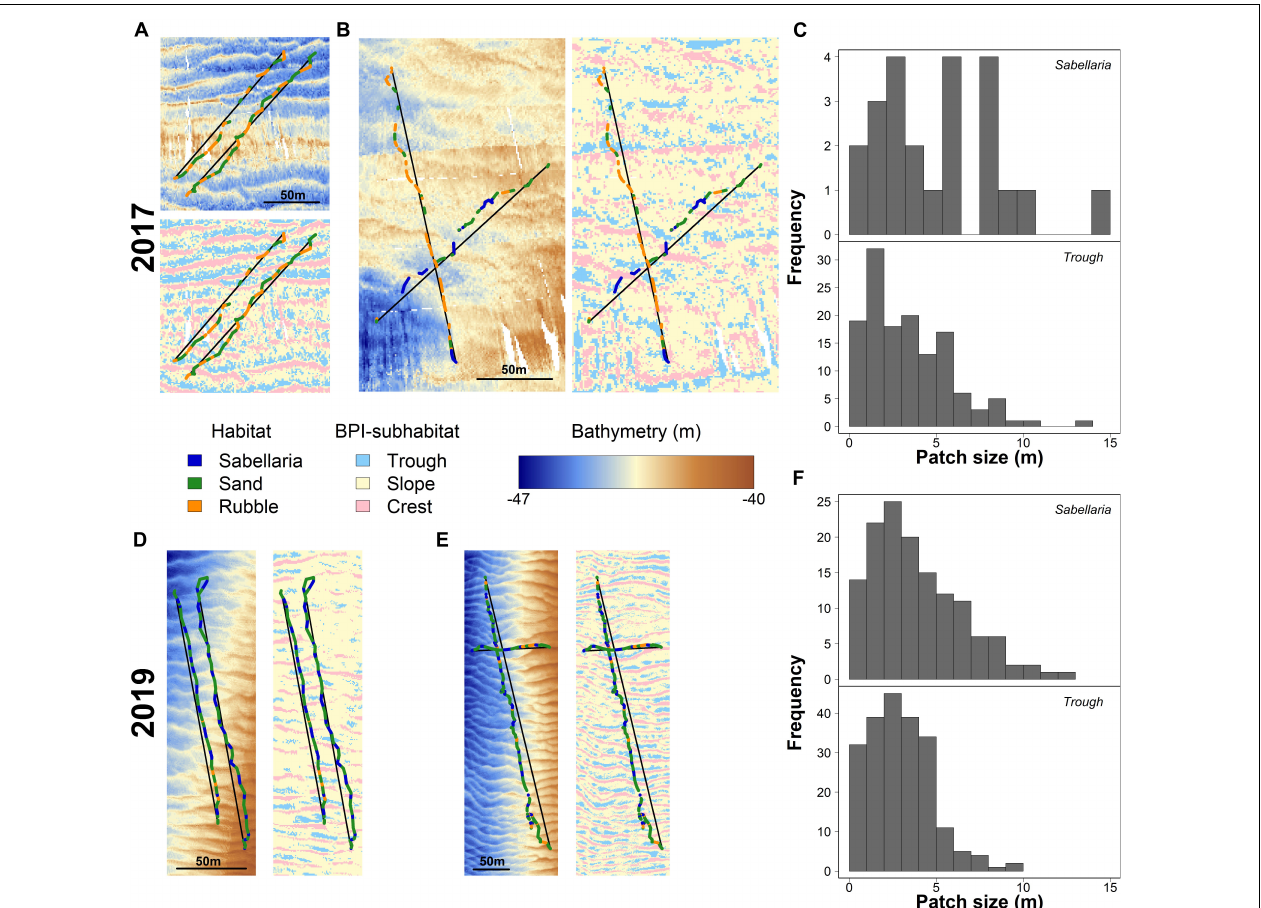
FIGURE 4 | Habitat patch distributions and their link to seafloor morphology for 2017 (A–C) and 2019 (D–F) . (A) detailed maps showing the bathymetry and BPI-subhabitats surrounding the video-observed habitat patches (Sabellaria in blue, Sand in green, and Rubble in Orange) for two representative video transects gathered in 2017 in the western trough. Black lines represent the line segments used to determine BPI-subhabitat sizes. Similar maps of bathymetry and BPI-subhabitat overlayed with video-observed habitats are shown for (B) 2017, eastern trough, (D) 2019, western trough, and (E) 2019, eastern trough. Histograms show the absolute frequency of the sizes for the video-observed Sabellaria habitat patches and BPI-subhabitats “trough” for 2017 (C) and 2019 (F) .